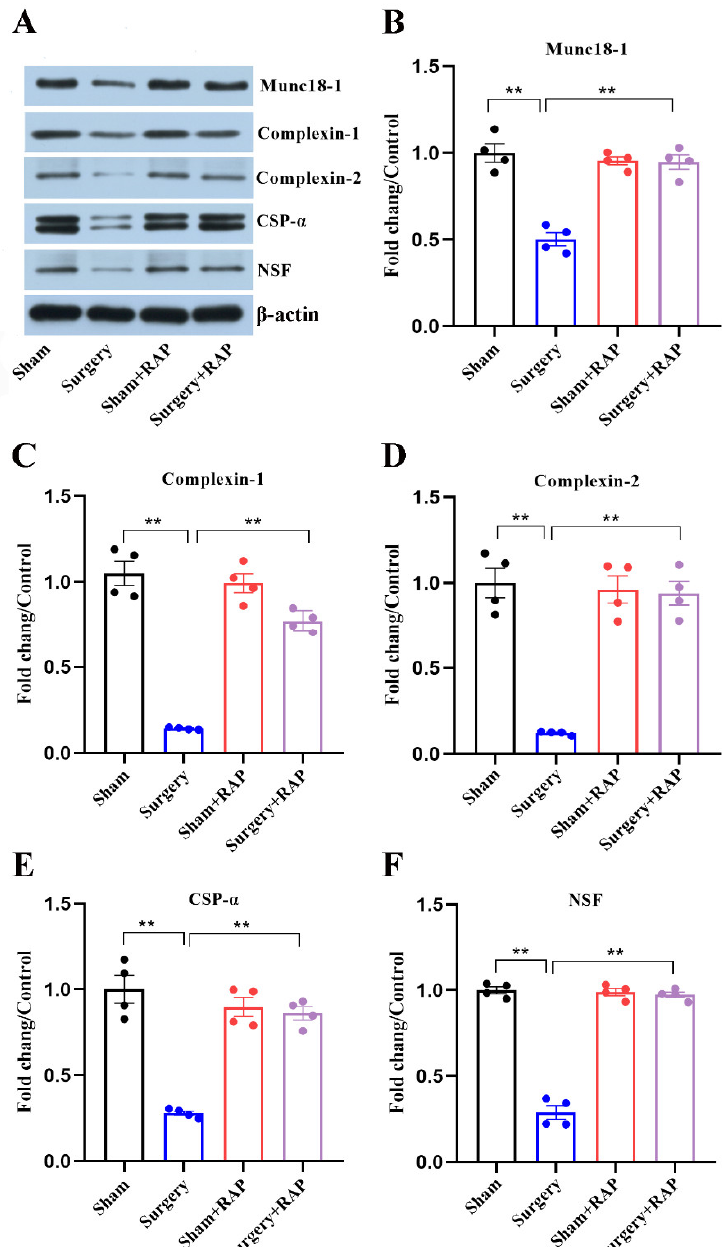
Figure 4. Rapamycin alleviated disturbances in the levels of SNARE chaperones in hippocampal synaptosomes caused by surgery. ( A ) Representative immunoblot of SNARE chaperones in hippocampal synaptosomes. ( B ) Munc18-1, ( C ) complexin 1, ( D ) complexin 2, ( E ) CSPα, and ( F ) NSF were quantified by densitometry and normalized to GAPDH. Values represent the mean ± SEM, n = 4 per group. ** p < 0.01 surgery vs. sham group or surgery+rapamycin vs. surgery group. RAP: rapamycin.